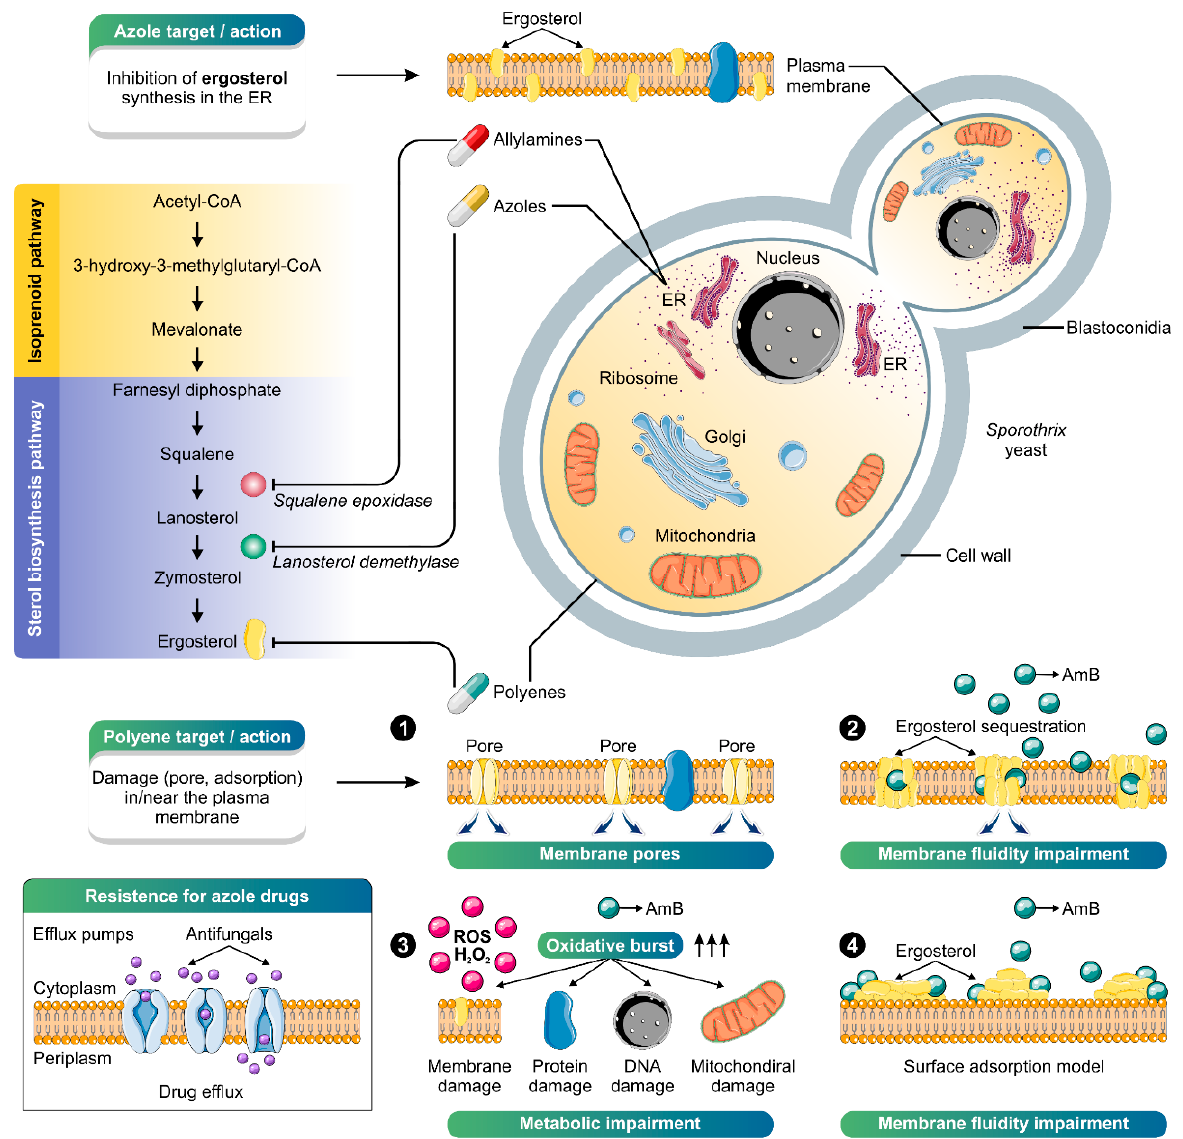
Figure 7. The main antifungal agents used in treating sporotrichosis and their cellular targets are depicted. Azoles (e.g., itraconazole) and allylamines (e.g., terbinafine) are fungistatic drugs that slow fungal growth; the azoles by inhibiting cytochrome P-450-dependent synthesis of ergosterol (purple chart: sterol biosynthesis pathway) and the allylamines by competitive inhibition of squalene epoxidase, blocking the conversion of squalene to lanosterol. Amphotericin B is a fungicidal drug whose main target is the ergosterol molecule, producing pores in the plasma membrane (1), leading to the leakage of cytoplasmic material, sequestering (2), absorbing or extracting ergosterol from the membrane (4). Oxidative damage is reported as an alternative mode of action of AmB (3). The main adaptation that can lead to resistance in Sporothrix species is the increased expression of efflux pumps, especially to azoles, although other mechanisms may be involved. The illustration was